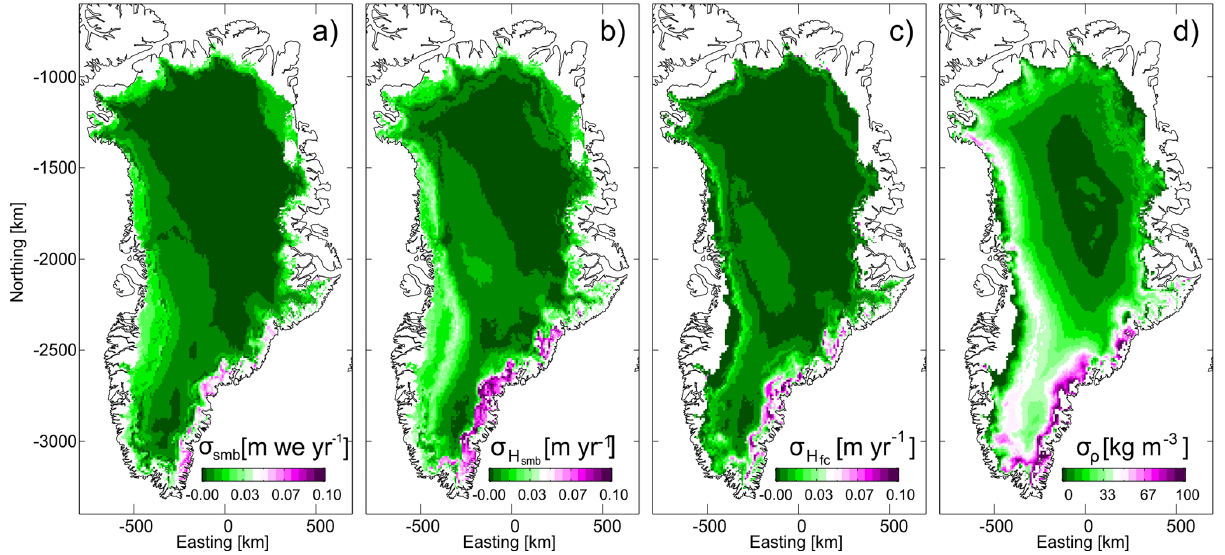
, σ H , and σ ρ as obtained by propagating errors in SMB and temperature from RACMO2 (Eq. 4) smb fc